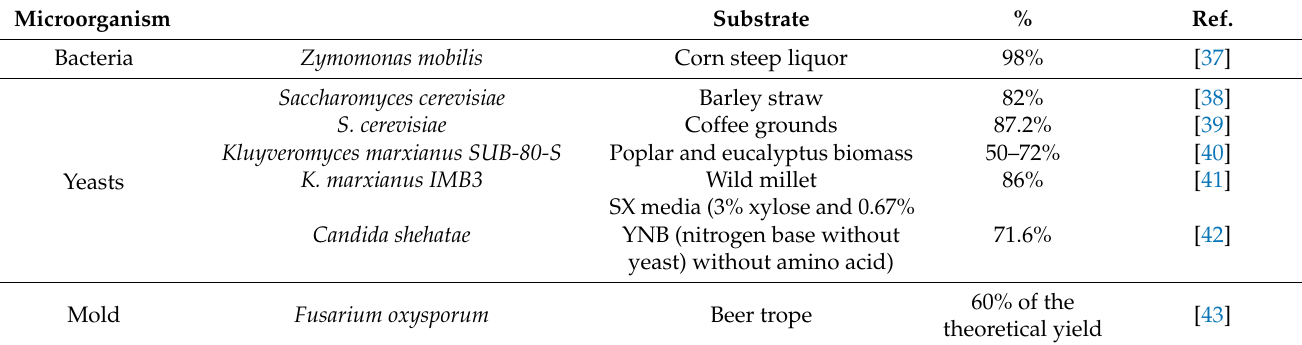
(Table 1) [35]. Bioethanol is the leading liquid biofuel, with a global production of 29 billion gallons in 2019. The top producers are the United States and Brazil, which account for 84% of global production [36]. Table 1. Bioethanol yield from different microorganisms.